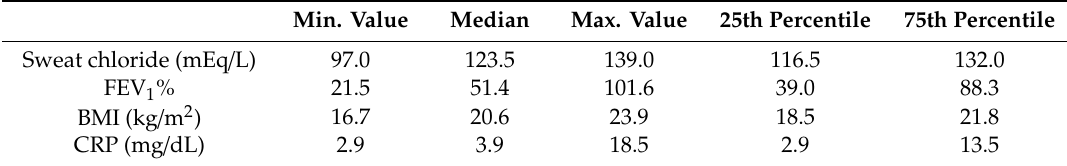
Table 1. Clinical characteristics of enrolled patients ( n = 14) before Orkambi ® treatment. Min. Value Median Max. Value 25th